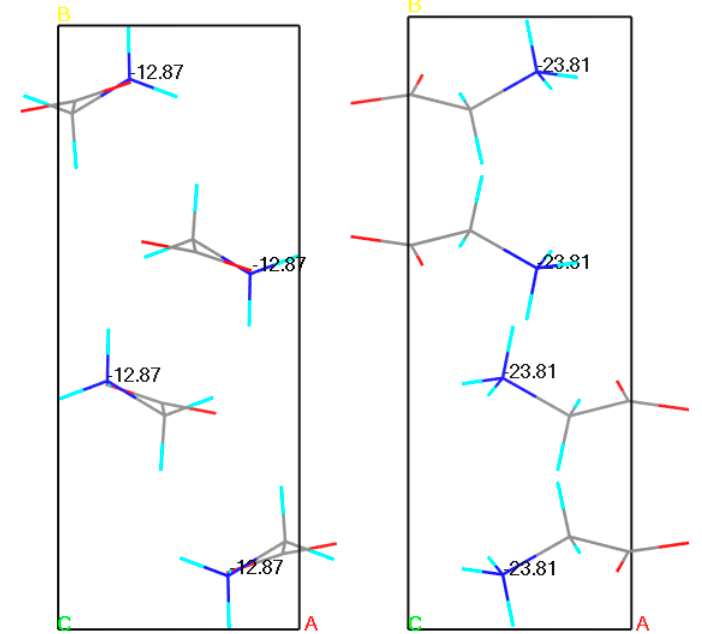
Figure 1. Results of Gauge Including Projector Augmented Waves Nuclear Magnetic Resonance (GIPAW NMR) chemical shielding anisotropy calculations for the N atom of the α glycine crystal structures. On the left powder X-ray diffraction (PXRD) structure ( − 12.87 ppm), on the right single crystal X-ray diffraction (SCXRD) structure ( − 23.81 ppm). Experimental value: − 12.35 ppm. Source: author’s archive, more details [71].